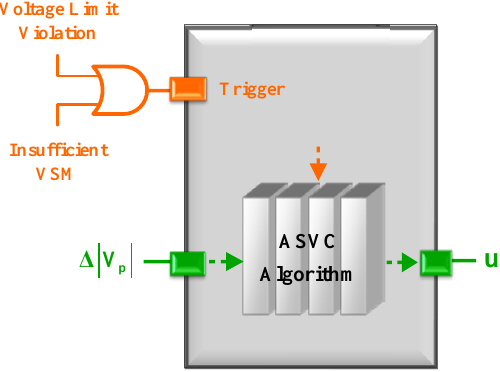
Figure 3. Block diagram of the proposed ASVC method. Once voltage limit violation or insufficient VSM is identified, the ASVC algorithm will be triggered automatically.